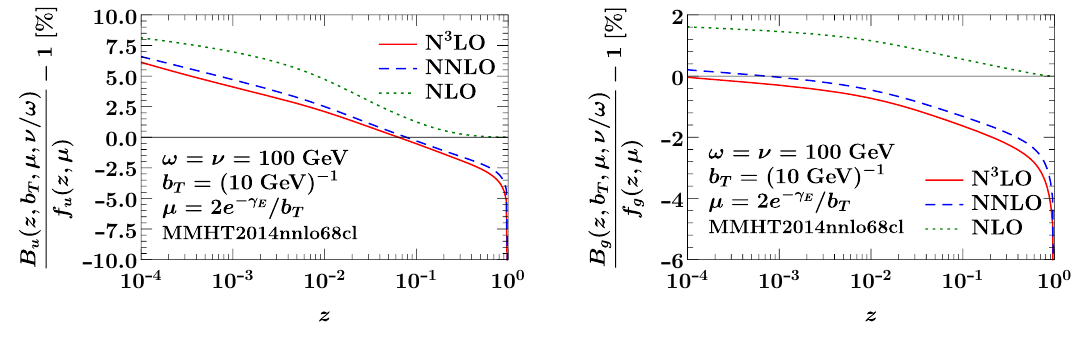
Figure 3 . The relative di(cid:11)erence of u -quark beam function (left) and the gluon beam function (right) to the corresponding PDF, as a function. We (cid:12)x b T = (10 GeV) (cid:0) 1 and ! = 100 GeV and choose the canonical scales (cid:22)b T = 2 e (cid:0) (cid:13) E and (cid:23) = ! . Note that with this choice of scales, the displayed beam function is the boundary term of a resummed